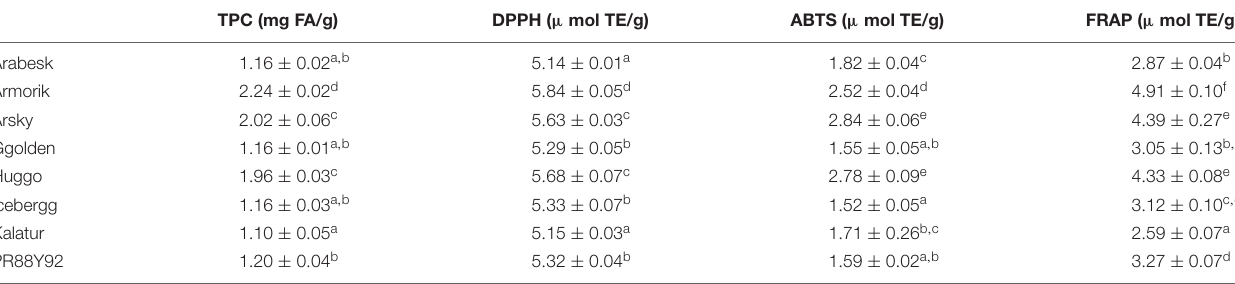
TABLE 8 | TPC and antioxidant activity of the flavonoids extracted from the eight varieties of sorghum. TPC (mg FA/g)